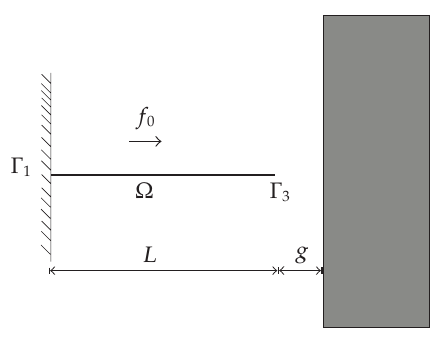
Figure 4.1 . Contact problem between a bar and a rigid